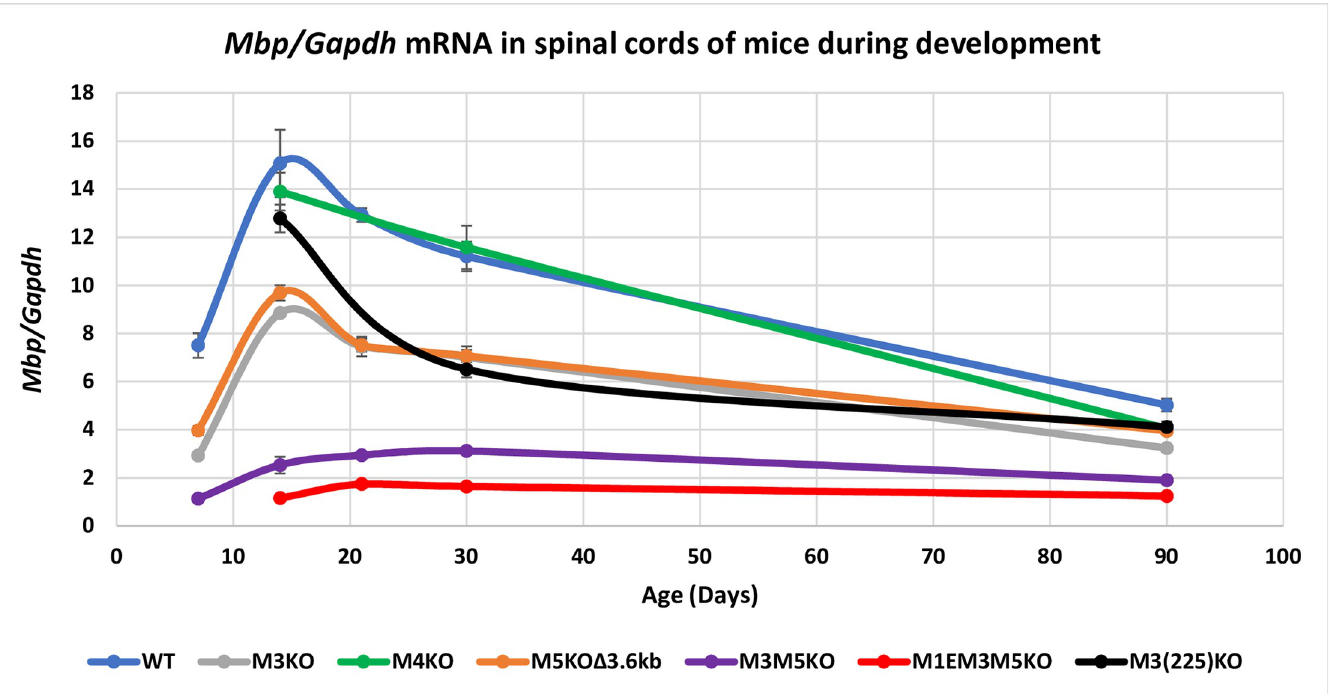
Fig 2. Relative Mbp mRNA accumulation in cervical spinal cord. M1E, M3 and M5 are major enhancers of Mbp in oligodendrocytes. X-axis = post-natal age in days and Y-axis = Mbp/Gapdh mRNA ratio. Dots represent values at P7, 14, 21, 30 and 90 and connecting lines are the predicted developmental programs calculated as trendlines (Excel). Error bars =